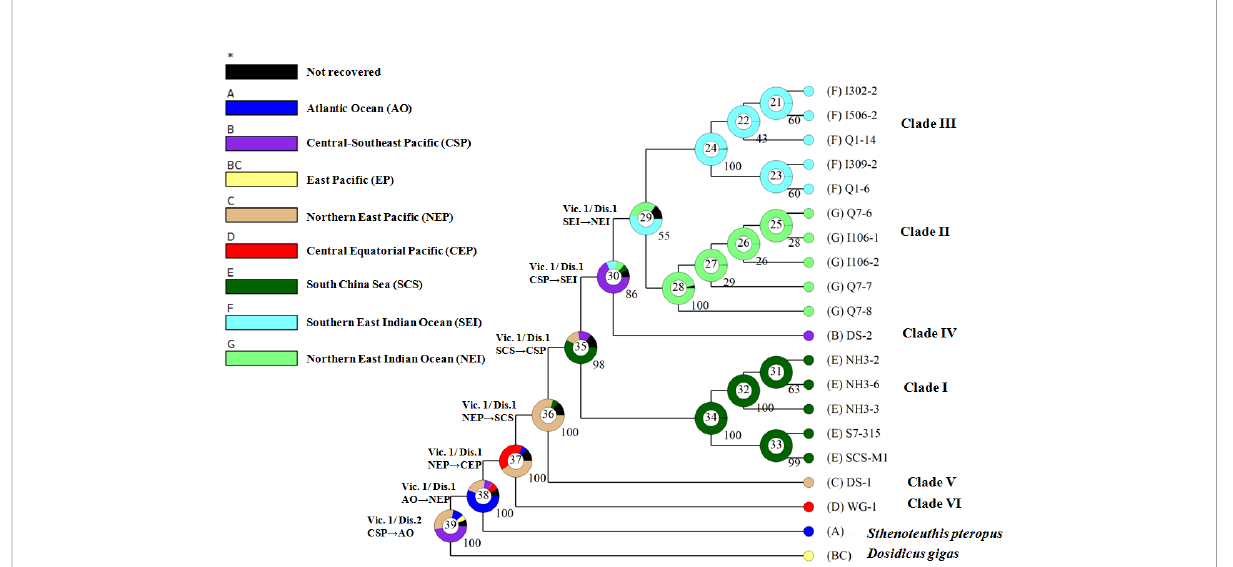
FIGURE 5 Historical biogeographic reconstruction of genus Sthenoteuthis and Dosidicus . Pie charts at each node show posterior probabilities of alternative ancestral distribution using different colors. Arrows show dispersal direction. Vic, vicariance; DIS, dispersal. Star "*" indicates lumped ranges with hidden probability less than 5%.